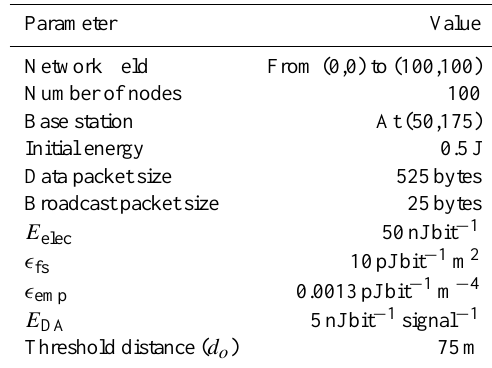
Figure 6. 100 wireless sensor nodes in the area of the sensing net- work. Table 1. Simulation